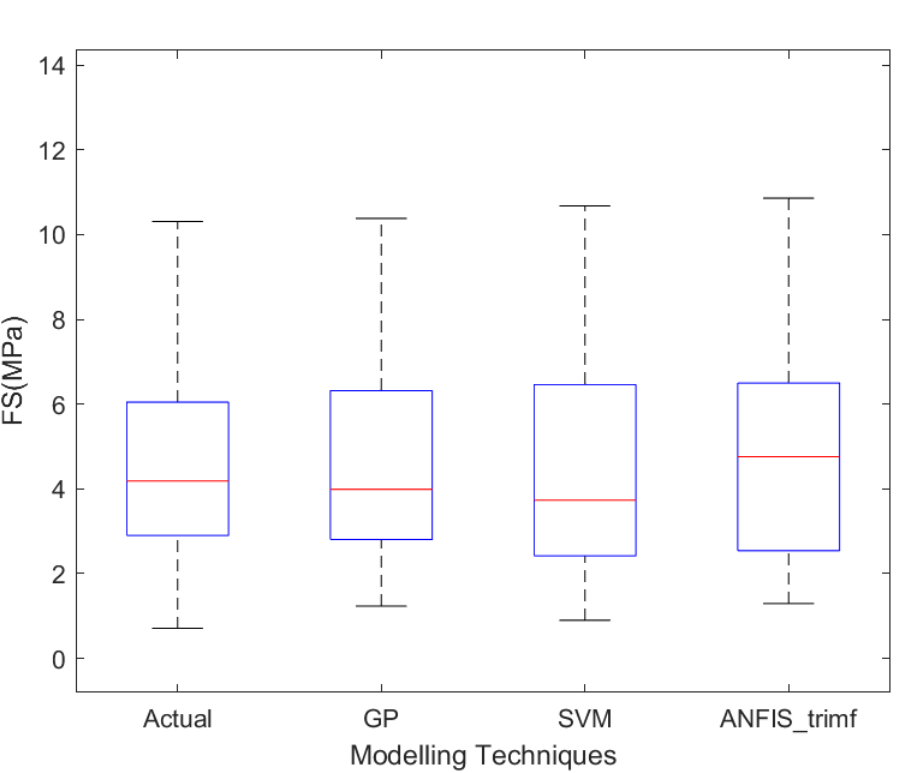
Figure 11. Box plots for all Testing Dataset models. Table 10. Statistics of observed and predicted output of testing dataset utilizing soft computing algorithms.